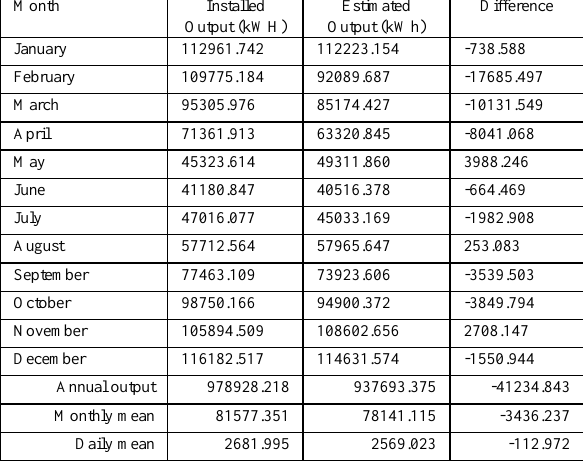
Table 3. Comparison between the installed and estimated